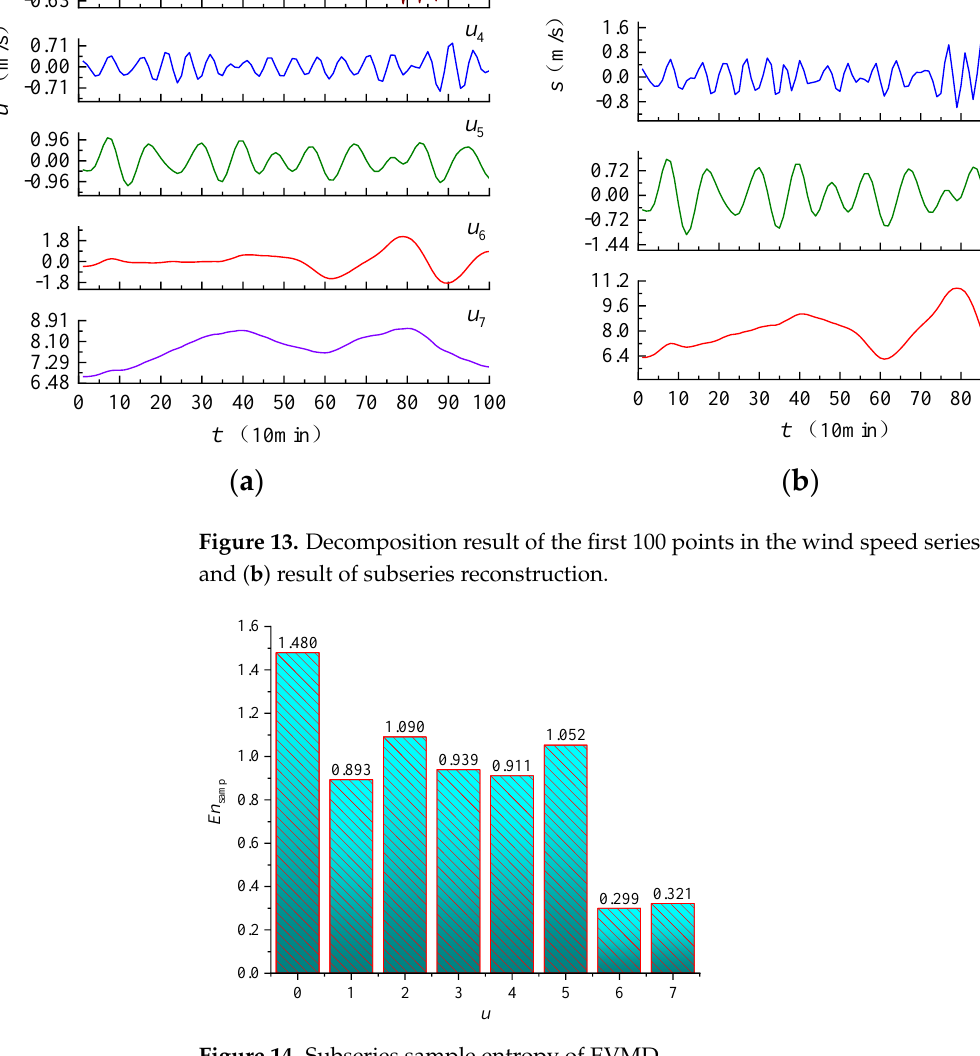
Figure 14. Subseries sample entropy of EVMD.